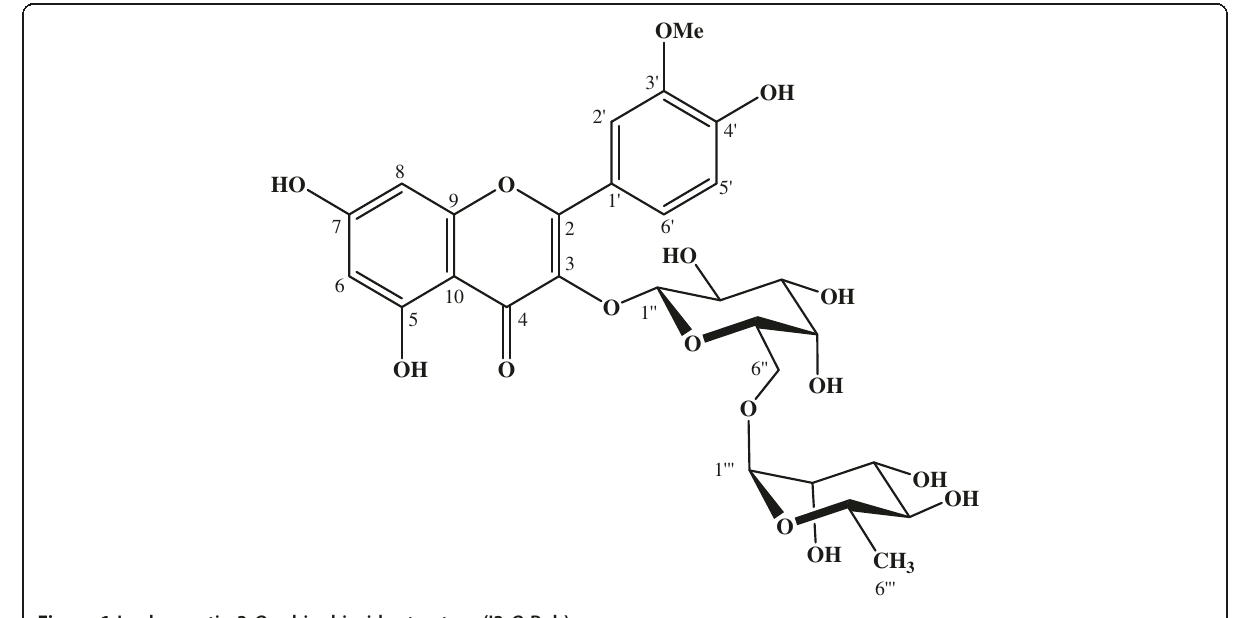
Figure 1 Isorhamnetin 3- O -robinobioside structure (I3- O